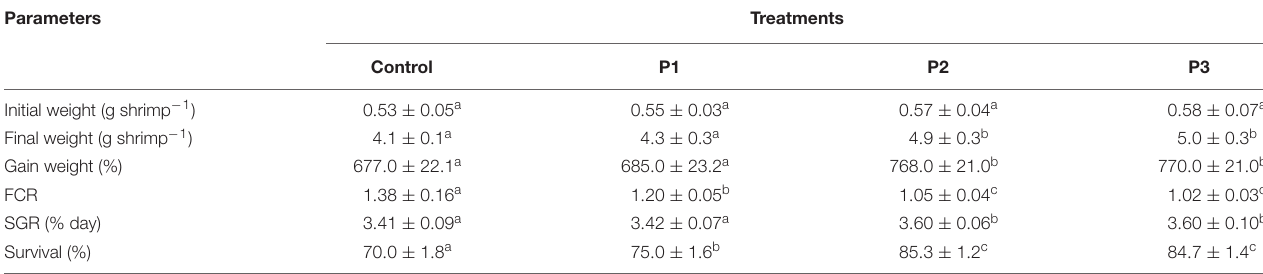
TABLE 2 | Growth performance of shrimp fed with different levels of P. pentosaceus .